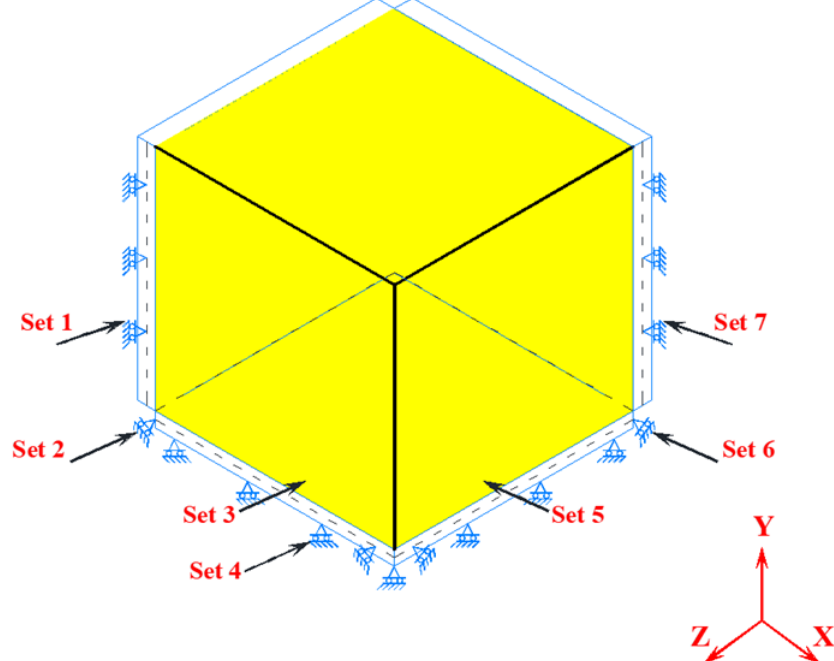
Figure 6. Boundary conditions assignment for one-quarter silo.